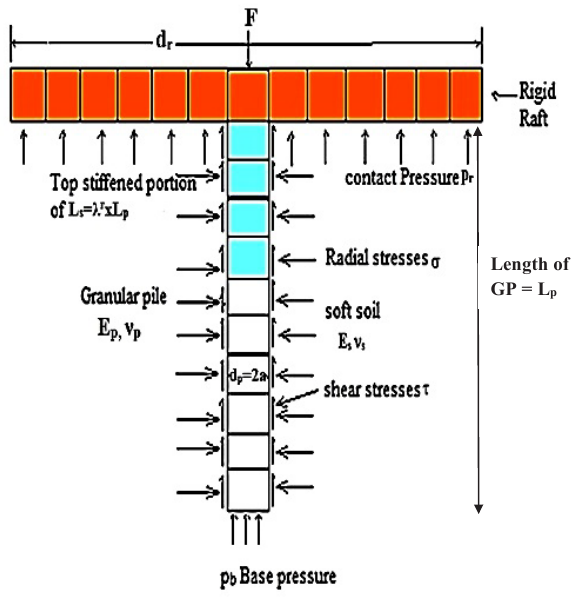
Figure 1: Force and stresses on a partially strengthened piled raft